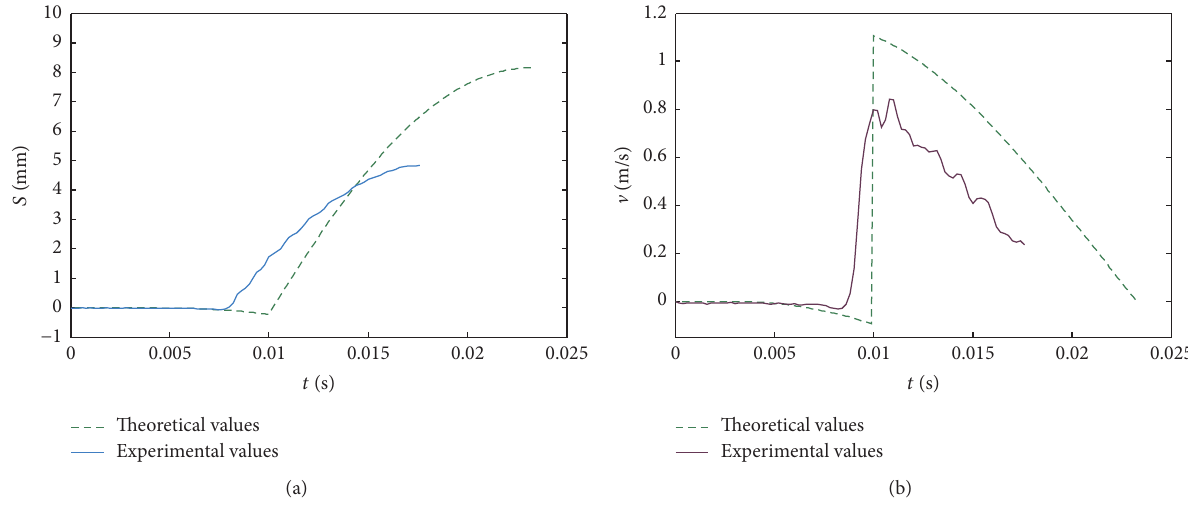
Figure 8: Comparison analysis between the theoretical and experiment base on B point. (a) The displacement curve with time. (b) The velocity curve with time. The collision conditions: 𝑀 0 = 801 g, 𝑀 1 = 355g, 𝑀 2 = 846 g, 𝑘 0 = 4.9 N/mm, and 𝑘 1 = 9.8